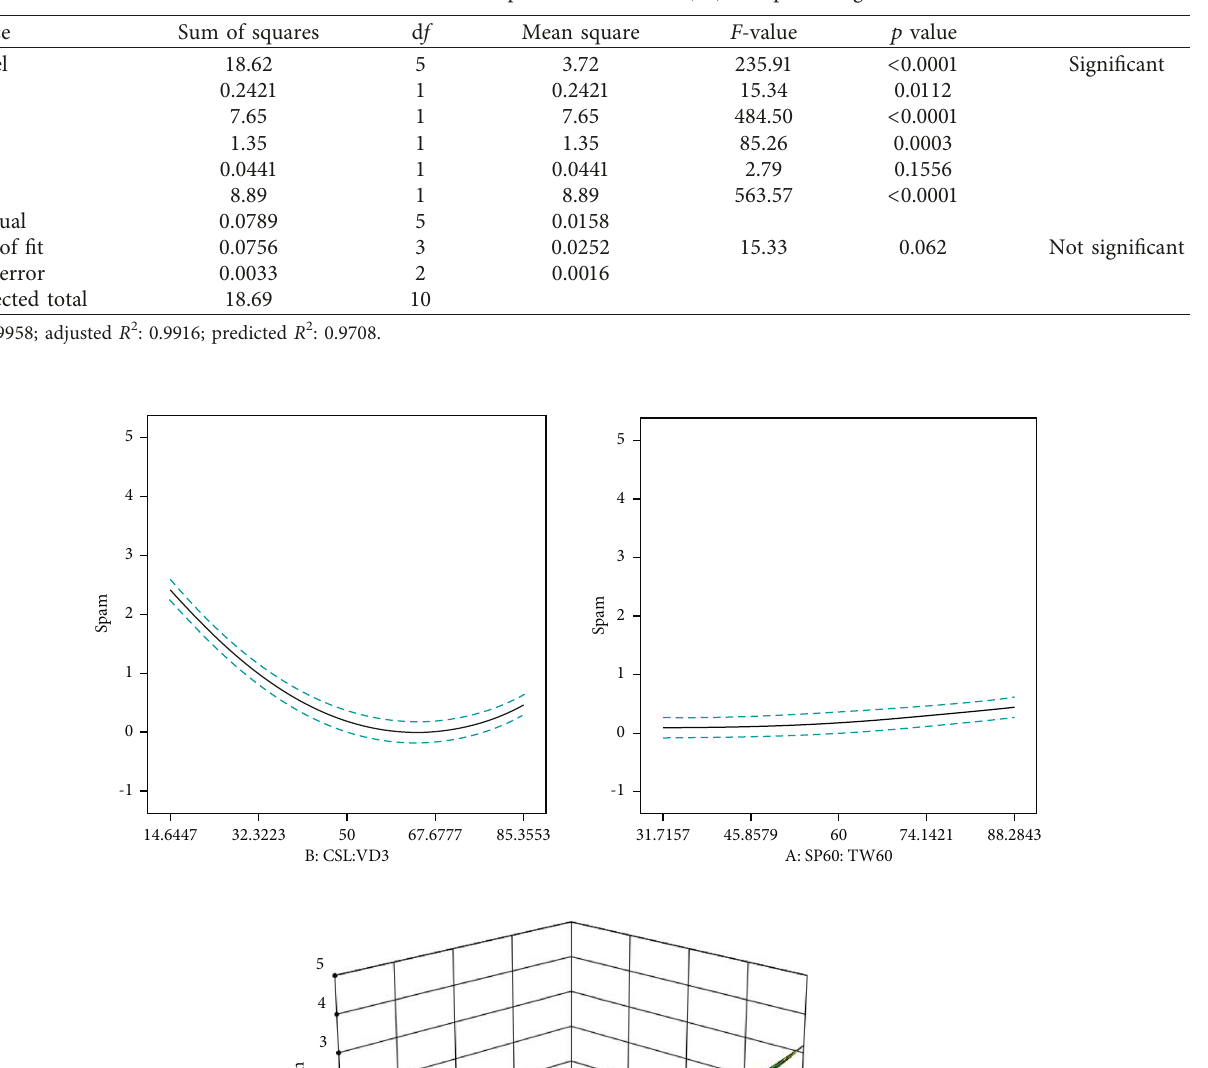
Table 3: Estimated coefficients of multiple determinations ( R 2 ) for span using coded